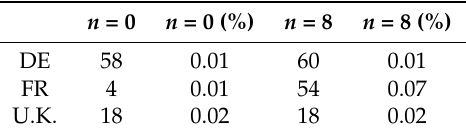
Table 6. Number of contributors with all or none of the